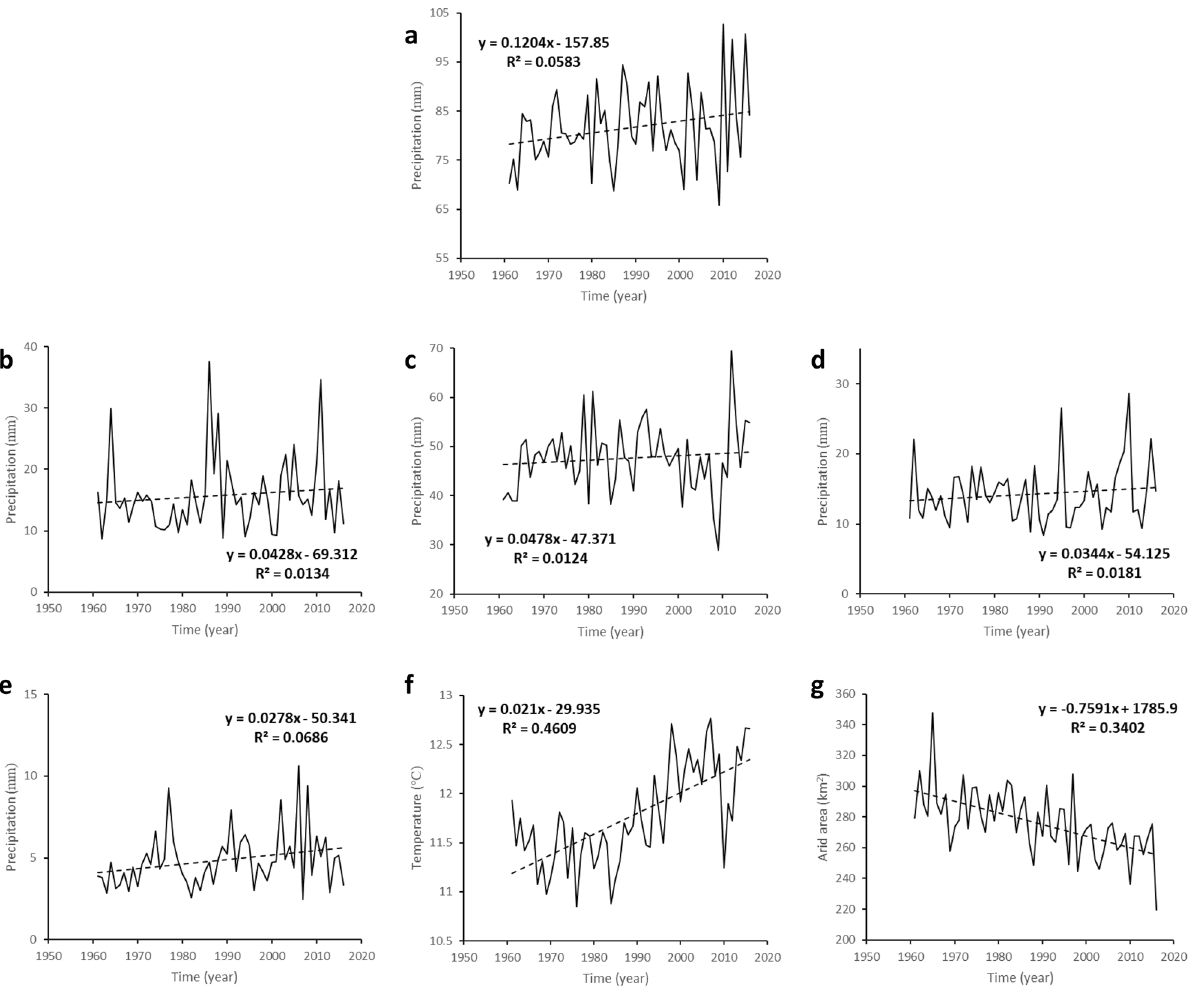
Figure 1. Change trends of annual and the seasonal precipitation, annual average temperature and area of China’s arid region during 1961–2016 ( a ) annual precipitation ( b ) spring precipitation ( c ) summer precipitation ( d ) autumn precipitation ( e ) winter precipitation ( f ) annual average temperature and ( g ) area of the arid